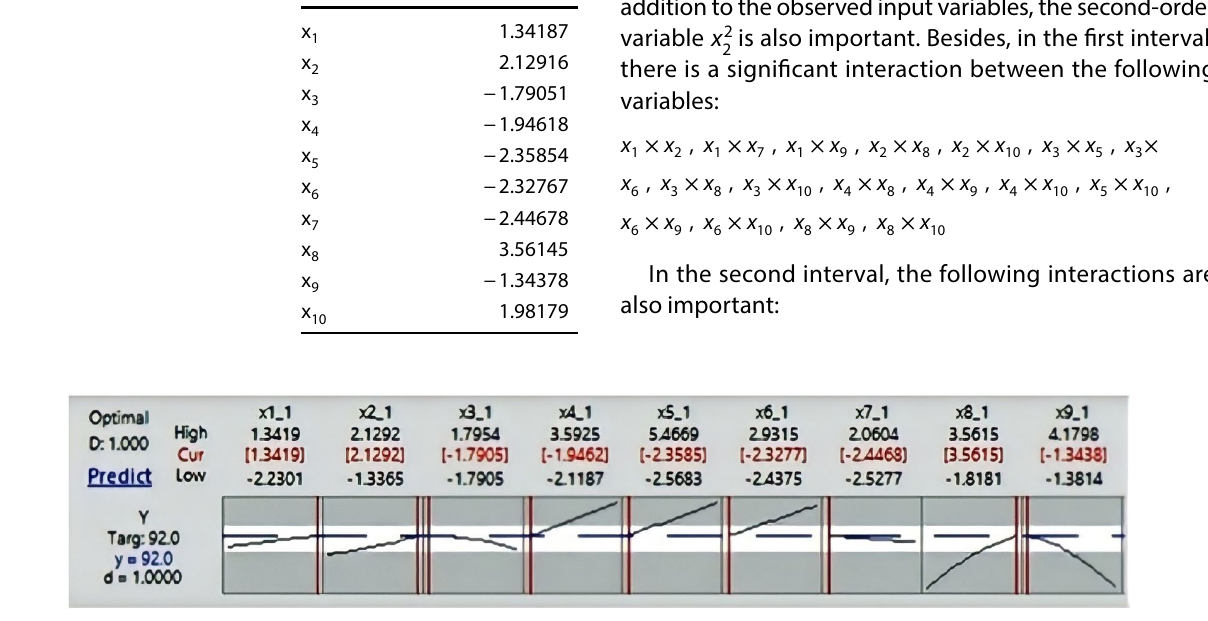
Fig. 8 Optimization plot for the first interval